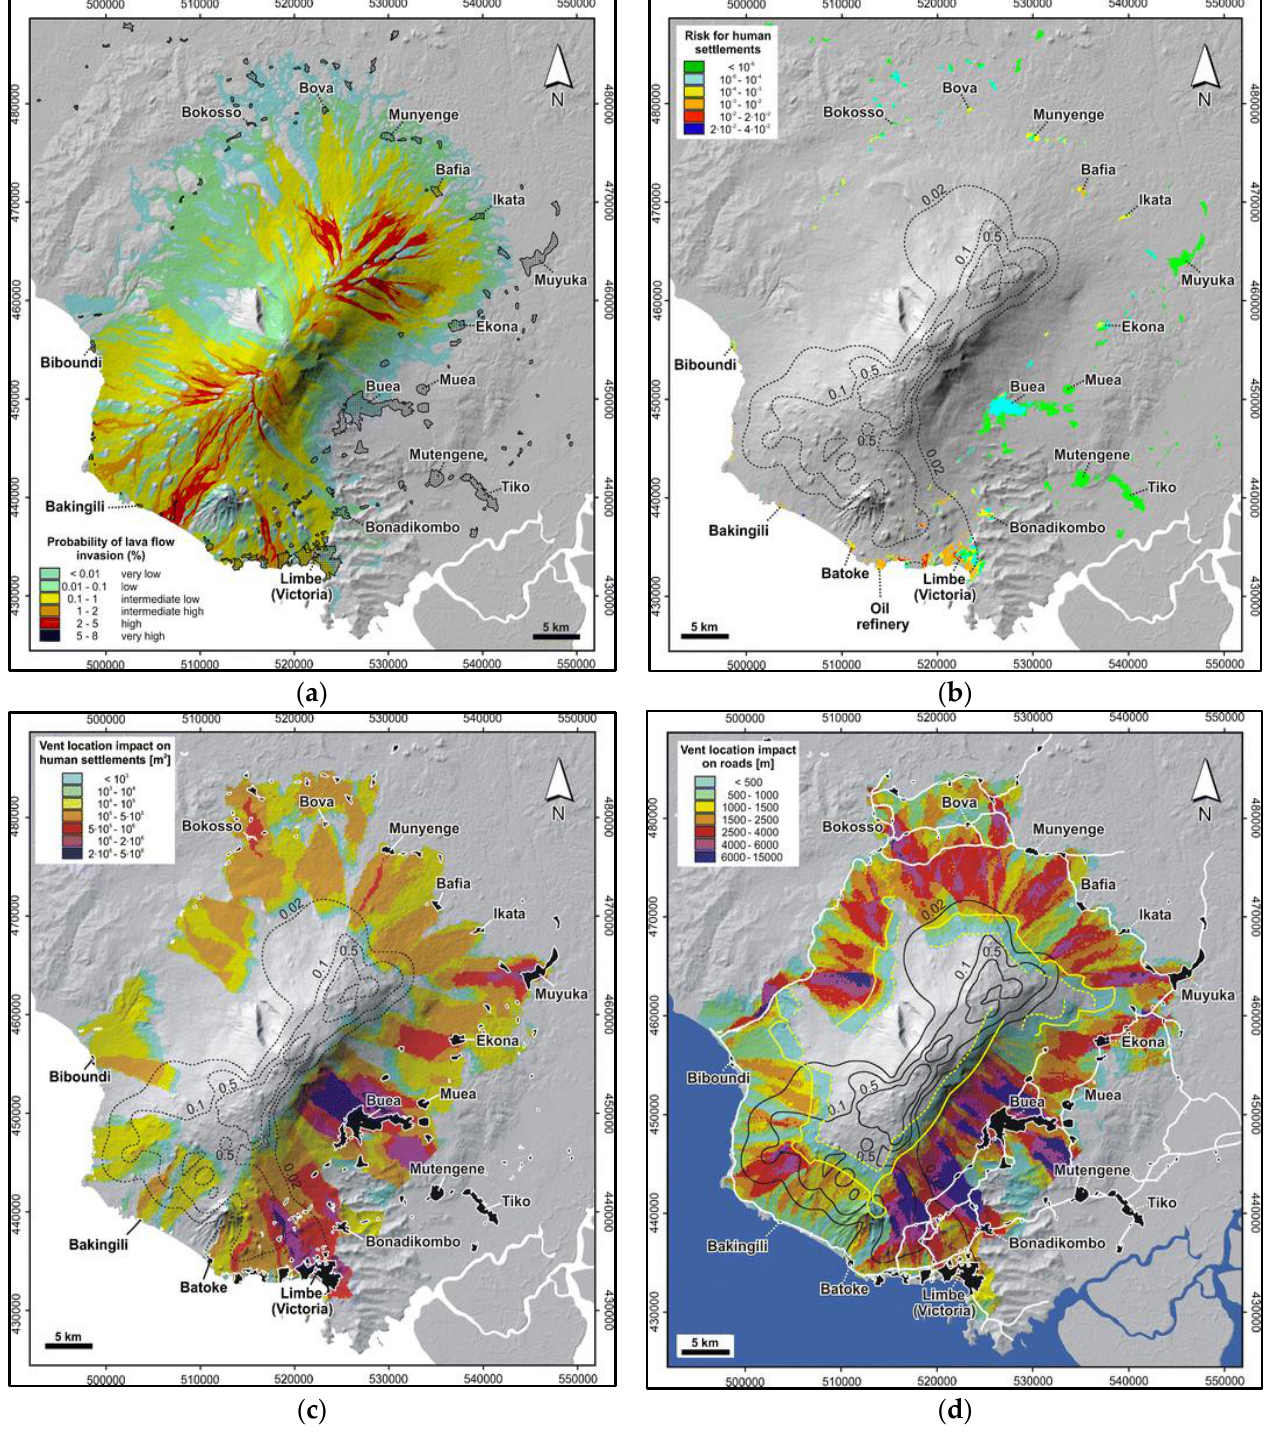
Figure 3. Risk maps of probability of lava flow inundation from Mt Cameroon. ( a ) Human settlements ( b ) Vent location impact on human settlements ( c ) Vent location impact on roads ( d ) Vent loccation on Mt Cameroon. Source: [11].